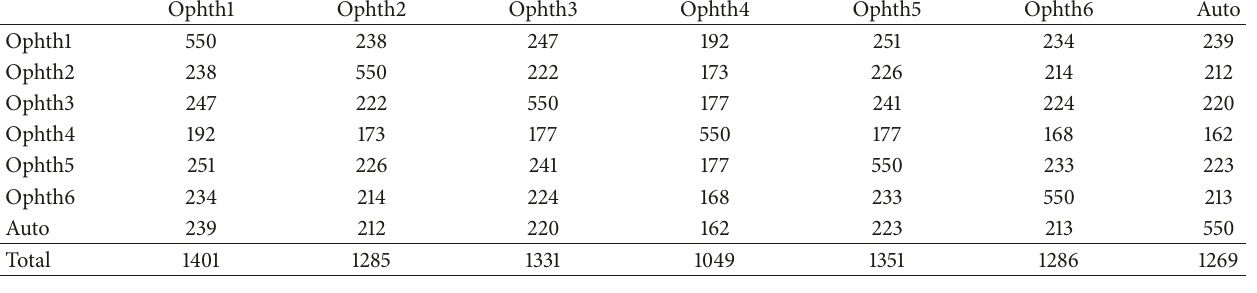
Table 6: The number of images agreed for the HCDR between the ophthalmologists as well as the algorithm.